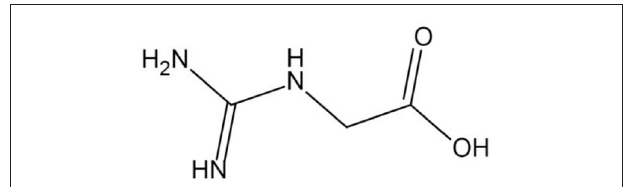
FIGURE 1 | The structure formula of guanidinoacetic acid